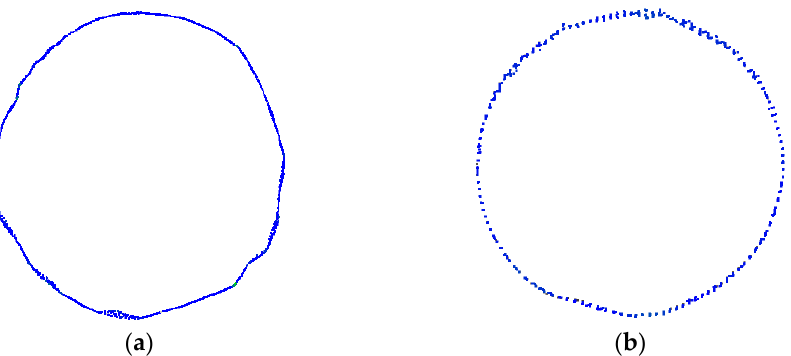
Figure A5. Sections of the point clouds of the stem of the statue; the scalar field refers to the surface variation value: 1.5 cm resolution scan performed at 2 m ( a ), 2 cm resolution scan performed at 2 m ( b ).